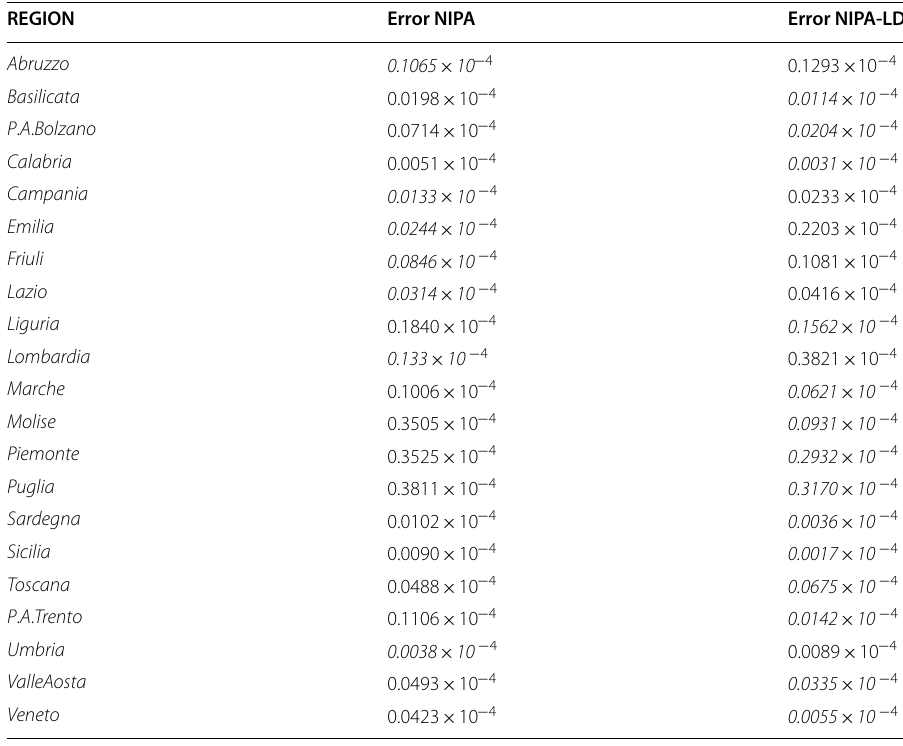
Table 2 Average MAPE prediction error of COVID‑19 deaths for NIPA and NIPA‑LD, when the number of neglected days is 30 REGION Error NIPA Error